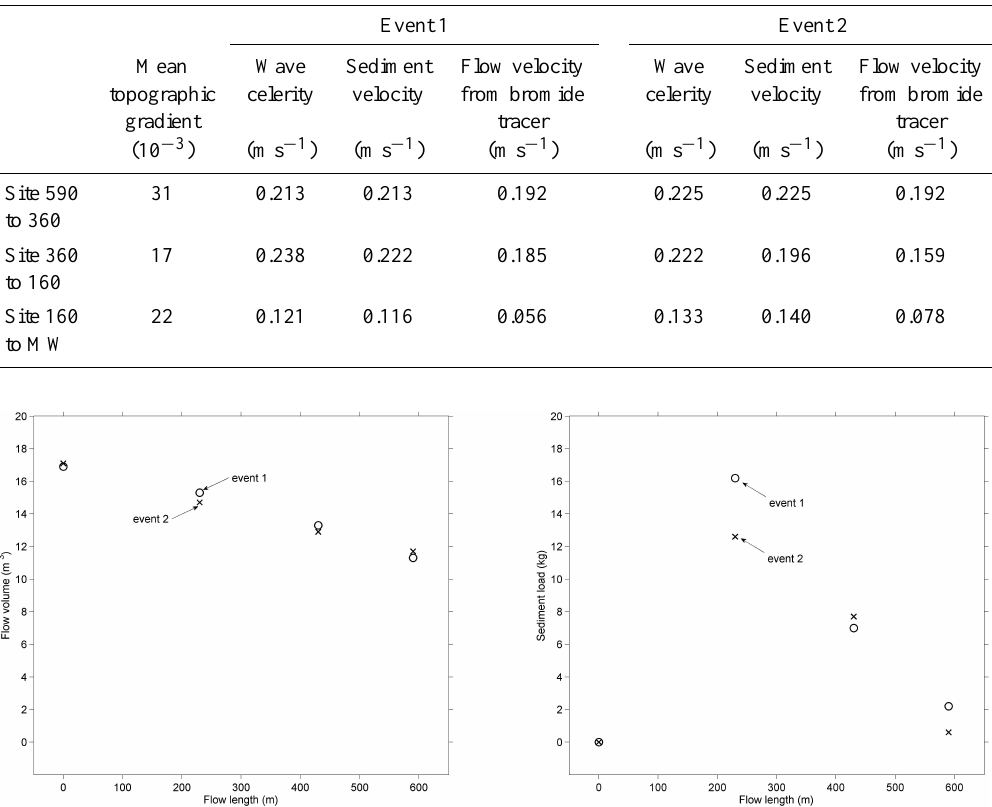
Fig. 8. Comparison of water volumes and sediment loads transported along the stream for the two flooding experiments (event 1 and event 2). Water flow is from left to